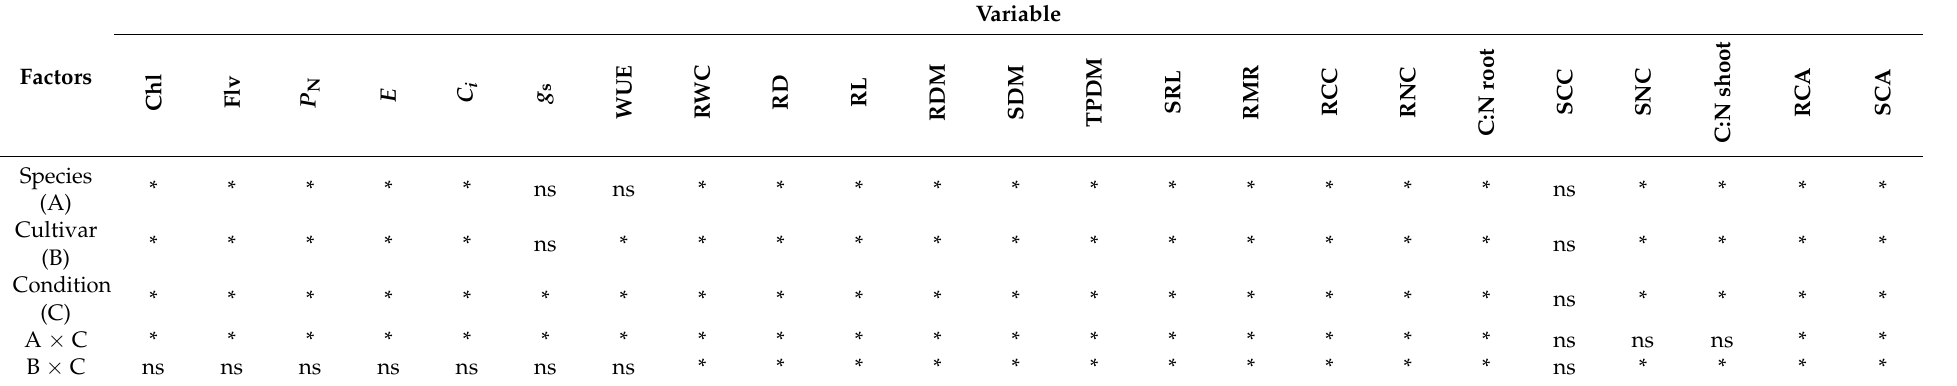
Table 2. Significance of the effect of factors and their interactions on the analyzed variables based on the analysis of variance.